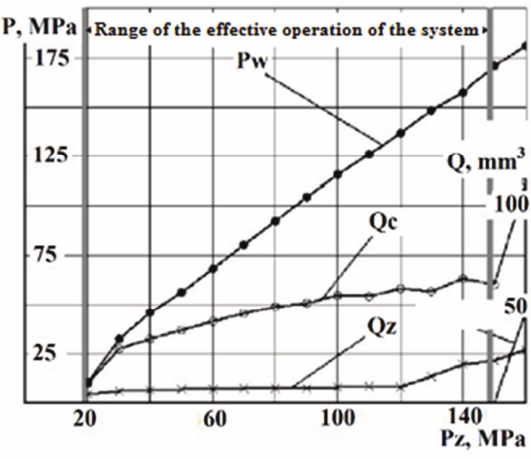
Fig. 4. Relation between injection parameters and pressure Rz for the system with an optimized injector